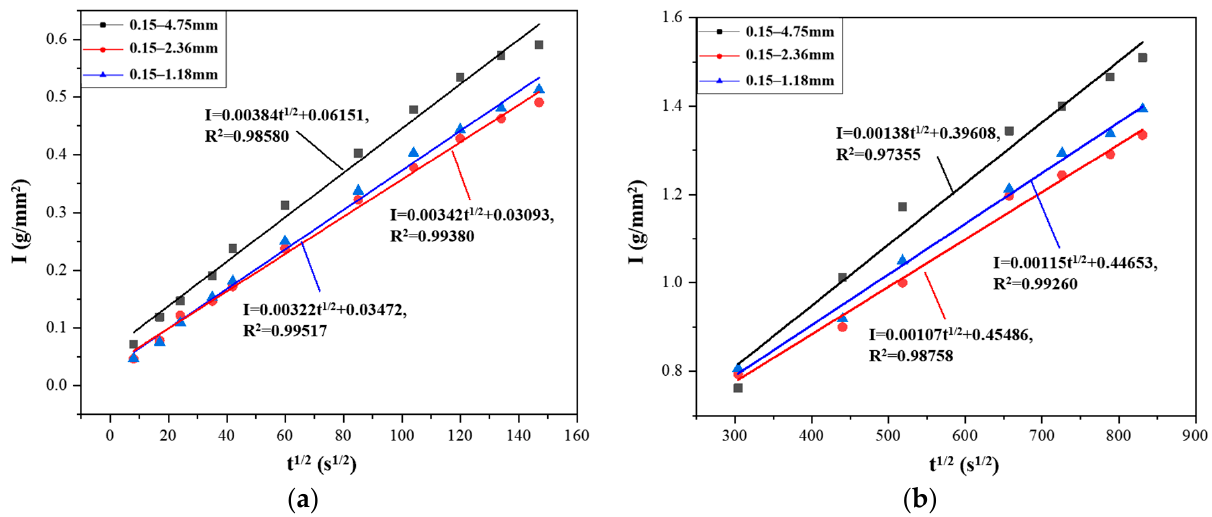
Figure 10. Effect of LWA with different particle sizes on water adsorption of L-UHPC; ( a ) initial adsorption; ( b ) secondary adsorption.